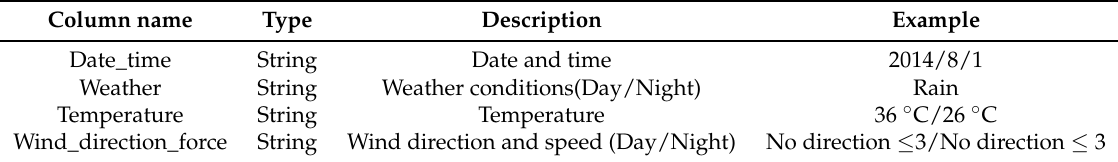
Table B1. Guangzhou weather